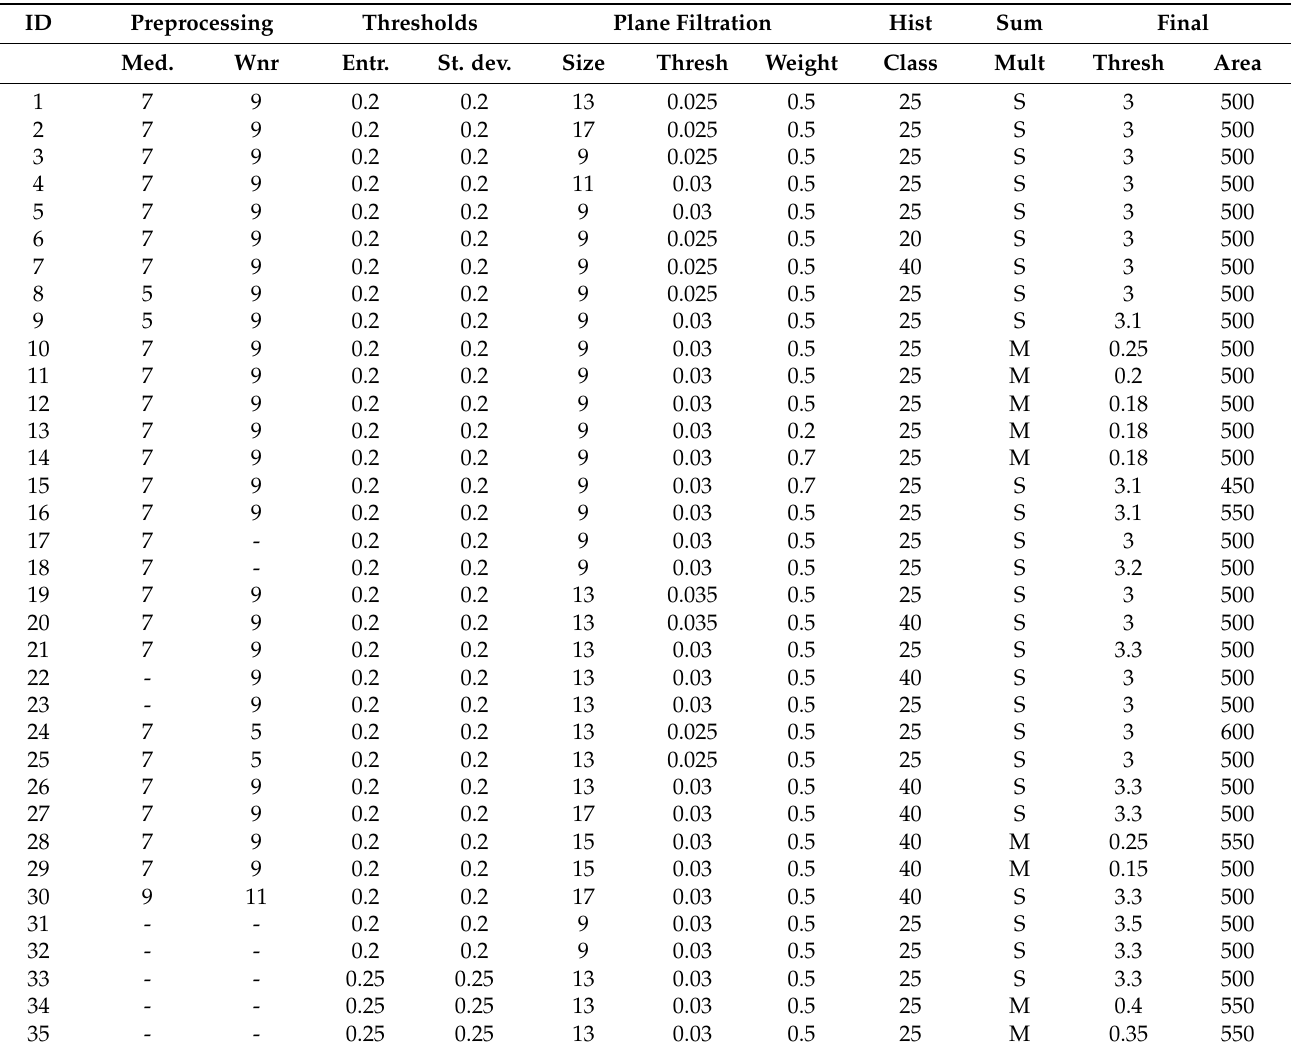
Table 1. Parameter values adopted at the stage of subsidence detection algorithm